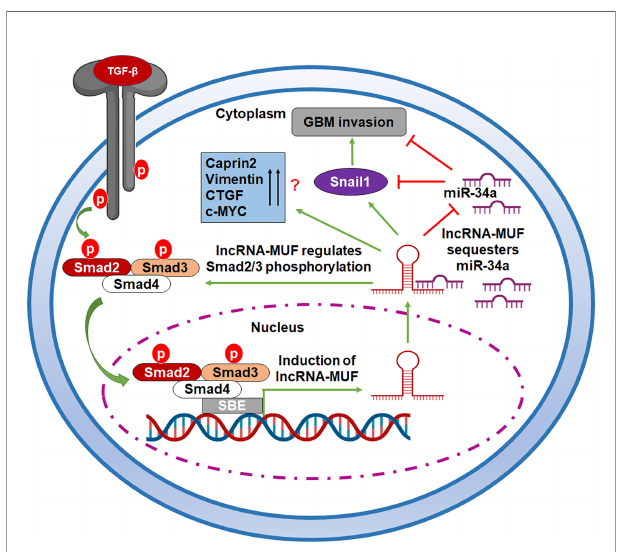
FIGURE 7 | A working model of TGF- b -activated lncRNA-MUF-driven glioma invasion. LncRNA-MUF is activated through the canonical TGF- b pathway, and it in turn regulates the phosphorylation of Smad2/3. It sequesters miR-34a from its binding target, Snail1, resulting in enhanced Snail1 expression and glioma invasion through the lncRNA-MUF/miR-34a/Snail1 signaling